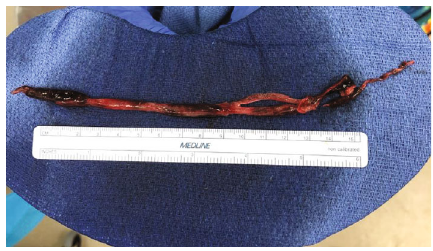
Figure 3: 22 cm thrombus removed by the aspiration